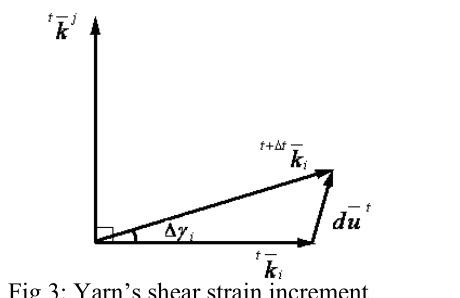
Fig 3: Yarn’s shear strain increment